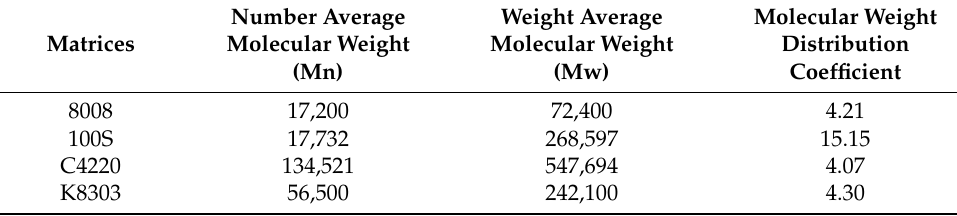
Table 1. Basic physical and mechanical properties of polymer matrices [24–27].